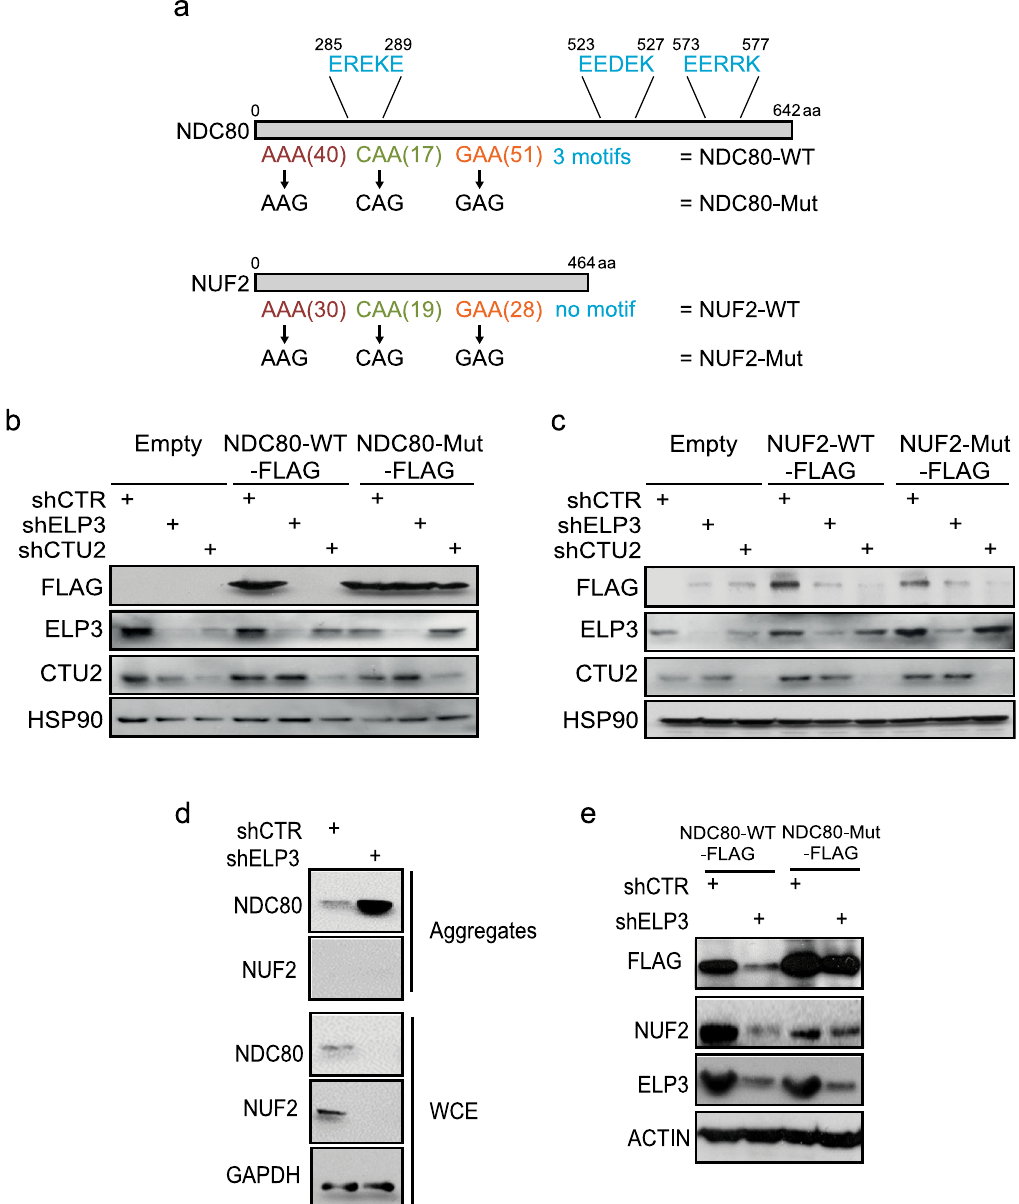
Fig. 6 The presence of hydrophilic motifs discriminates between direct and indirect targets of the U 34 -tRNA modi fi cation pathway. a Schematic representation of the NDC80 and NUF2 protein sequences. Hydrophilic motifs are indicated in blue. b Protein levels of indicated proteins in cells overexpressing control or NDC80-WT-FLAG or NDC80-Mut-FLAG constructs in the presence or absence of ELP3 or CTU2 ( n = 2 replicates). c Protein levels of indicated proteins in cells overexpressing control or NUF2-WT-FLAG or NUF2-Mut-FLAG constructs in the presence or absence of ELP3 or CTU2 ( n = 2 replicates). d Levels of indicated proteins were determined by western blot in whole-cell extracts (WCE) and aggregates of MCF7 cells depleted of ELP3 ( n = 2 replicates). e Levels of indicated proteins were determined by western blot in cells overexpressing NDC80-WT-FLAG or NDC80-Mut-FLAG constructs in the presence or absence of ELP3 ( n = 1